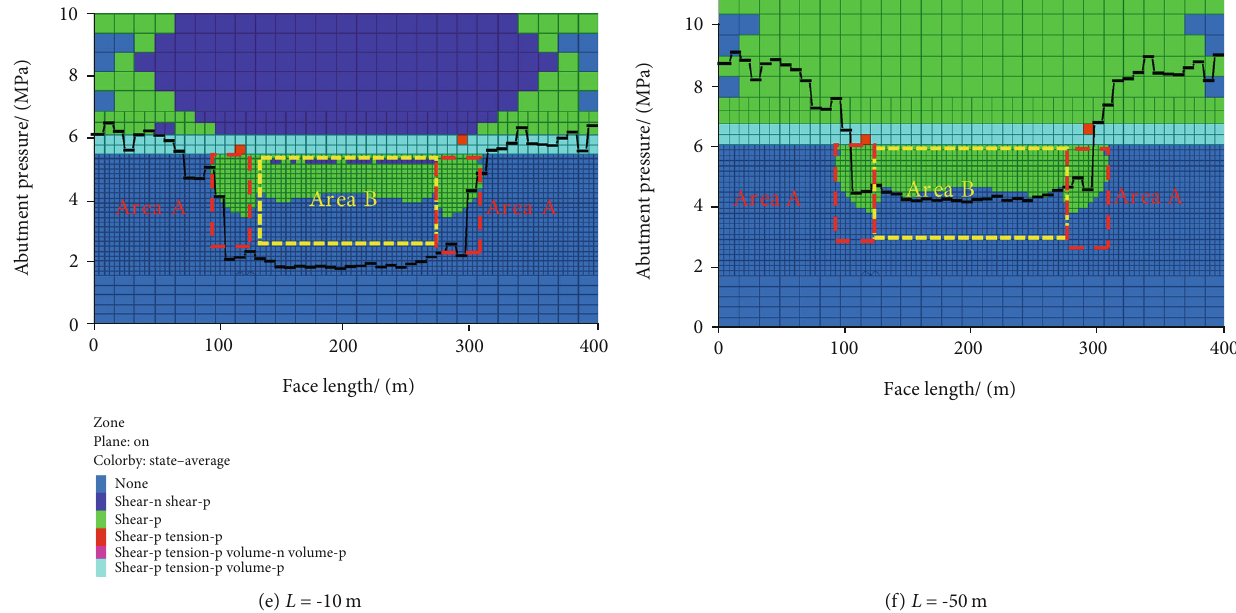
Figure 11: Abutment stress distribution and development of the plastic zone with plane y = 100 m